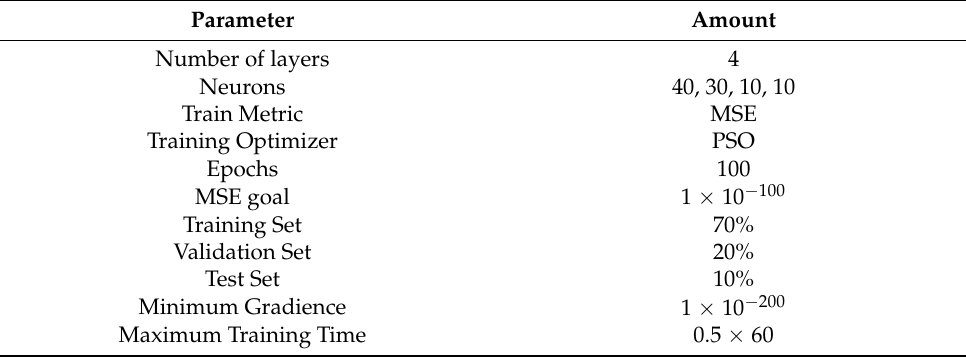
Table 3. FFNN-PSO model configurations and parameters.